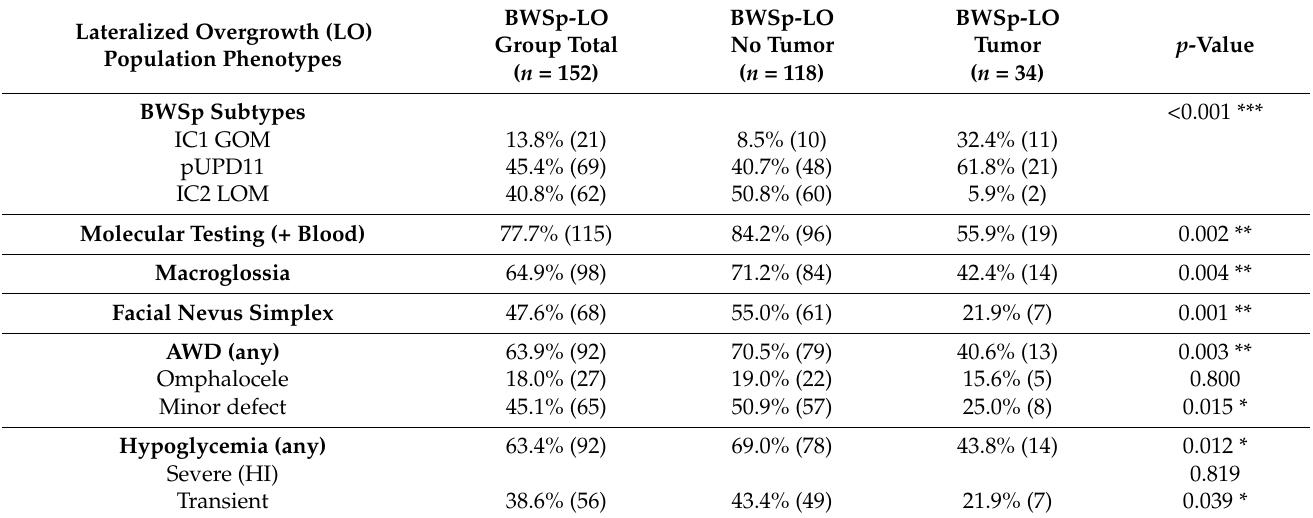
Table 6. Tumor phenotype associations within lateralized overgrowth (BWSp-LO) population. Lateralized Overgrowth